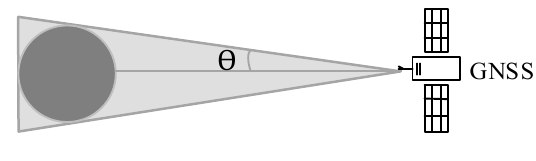
Figure 6. Earth block angle. Table 6. Earth block angles of different system